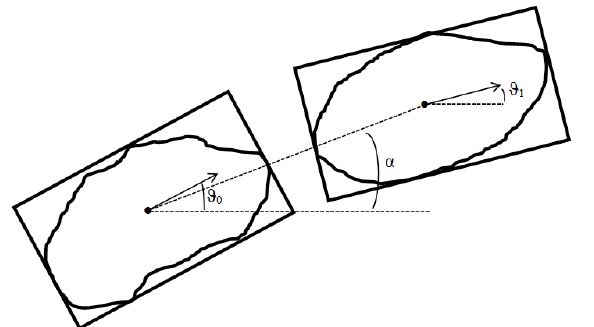
Figure 4: Creation of Minimum Bounding Boxes (MBB) and representation of ϑ 0 , ϑ 1 and α angles for the implementation of alignment rule between PPSA